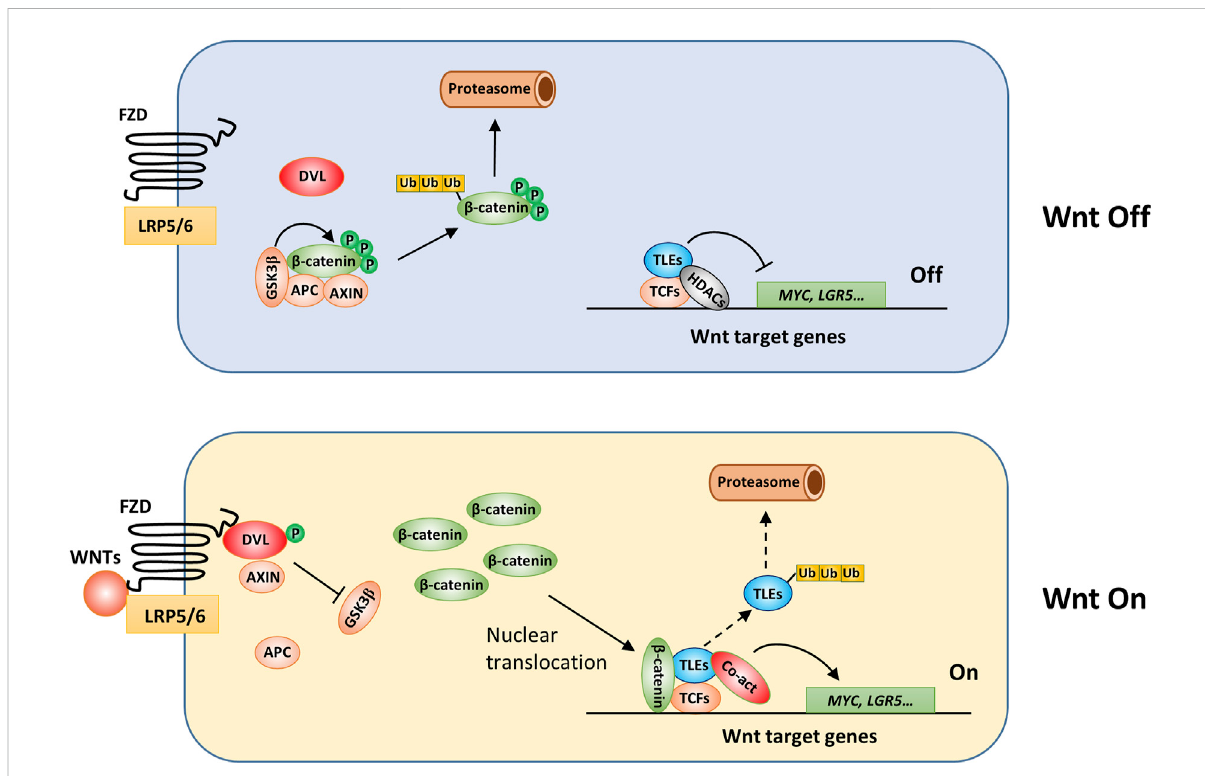
FIGURE 4 TheinvolvementofTLEsinregulationofclassicalWntsignaling.Underbaselineconditions,long-typeTLEsbindTCF/LEF1familyproteins(TCFs) through their Q domain and HDACs through the GP domain and thus inhibit the expression of Wnt target genes (Brantjes et al., 2001), such as MYC and LRG5 (Bottomly et al., 2010; Kim et al., 2017). TLE5 may interact speci fi cally with TCF3/4 to downregulate Wnt signaling (Costa et al., 2013). Wnt activation induces Dishevelled (DVL) protein phosphorylation and the subsequent dissociation of the ß -catenin destruction complex. Therefore, ß -catenin accumulates in the cytoplasm. After translocation to the nucleus, ß -catenin is recruited by TCFs to the promoter of Wnt target genes,whereitformsacomplexwithcoactivatorsanddrivesthetranscriptionofWnttargetgenes(Duchartreetal.,2016).TLEsmaybeubiquitinated and subsequently degraded (Hanson et al., 2012; Flack et al., 2017); however, the precise mechanisms remain